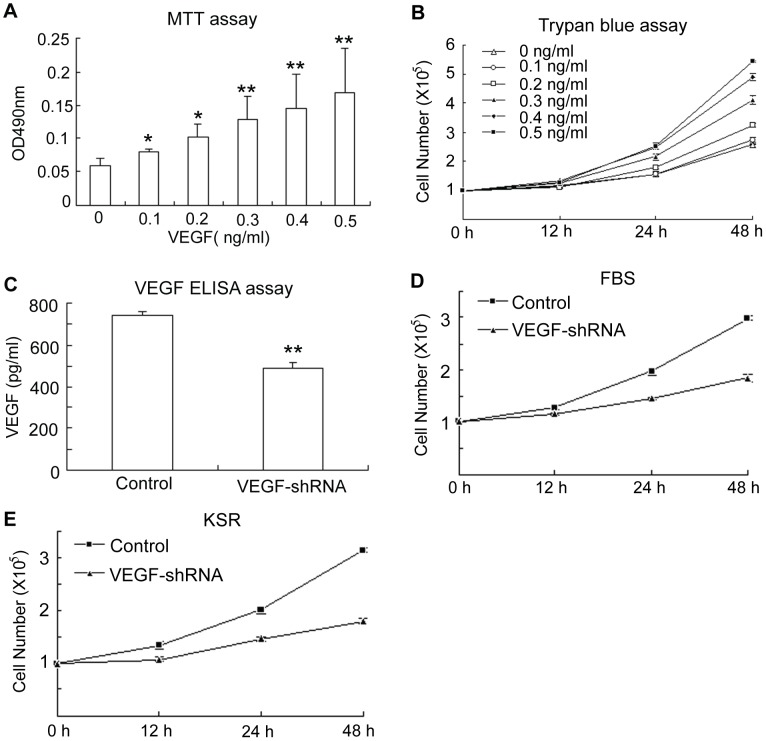
VEGF-mediated proliferation of ADSCs.(A) MTT assay indicated that proliferation of ADSCs was accelerated by supplementation of a gradient concentration of VEGF (n = 5); (B) Trypan blue staining confirmed that the effect of VEGF on ADSC proliferation was dose-dependent (n = 3, p<0.01); (C) ELISA assay indicated that VEGF expression was reduced by approximately 40% in ADSCs after shRNA silencing (n = 5, p<0.01); (D) Cell number was significantly reduced when ADSCs were cultured in FBS-containing medium for 24 or 48 hours after VEGF silencing (n = 3, P<0.01); (D) The cell number reduction was also confirmed when ADSCs were cultured for 24 or 48 hours in KSR-containing medium after VEGF silencing (n = 3, P<0.01); (E) ADSC proliferation was also evaluated in FBS medium by trypan blue assay when VEGF expression was knocked down, it was demonstrated that VEGF reduction resulted in inhibition of ADSC proliferation (n = 5). * P<0.05, **P<0.01.